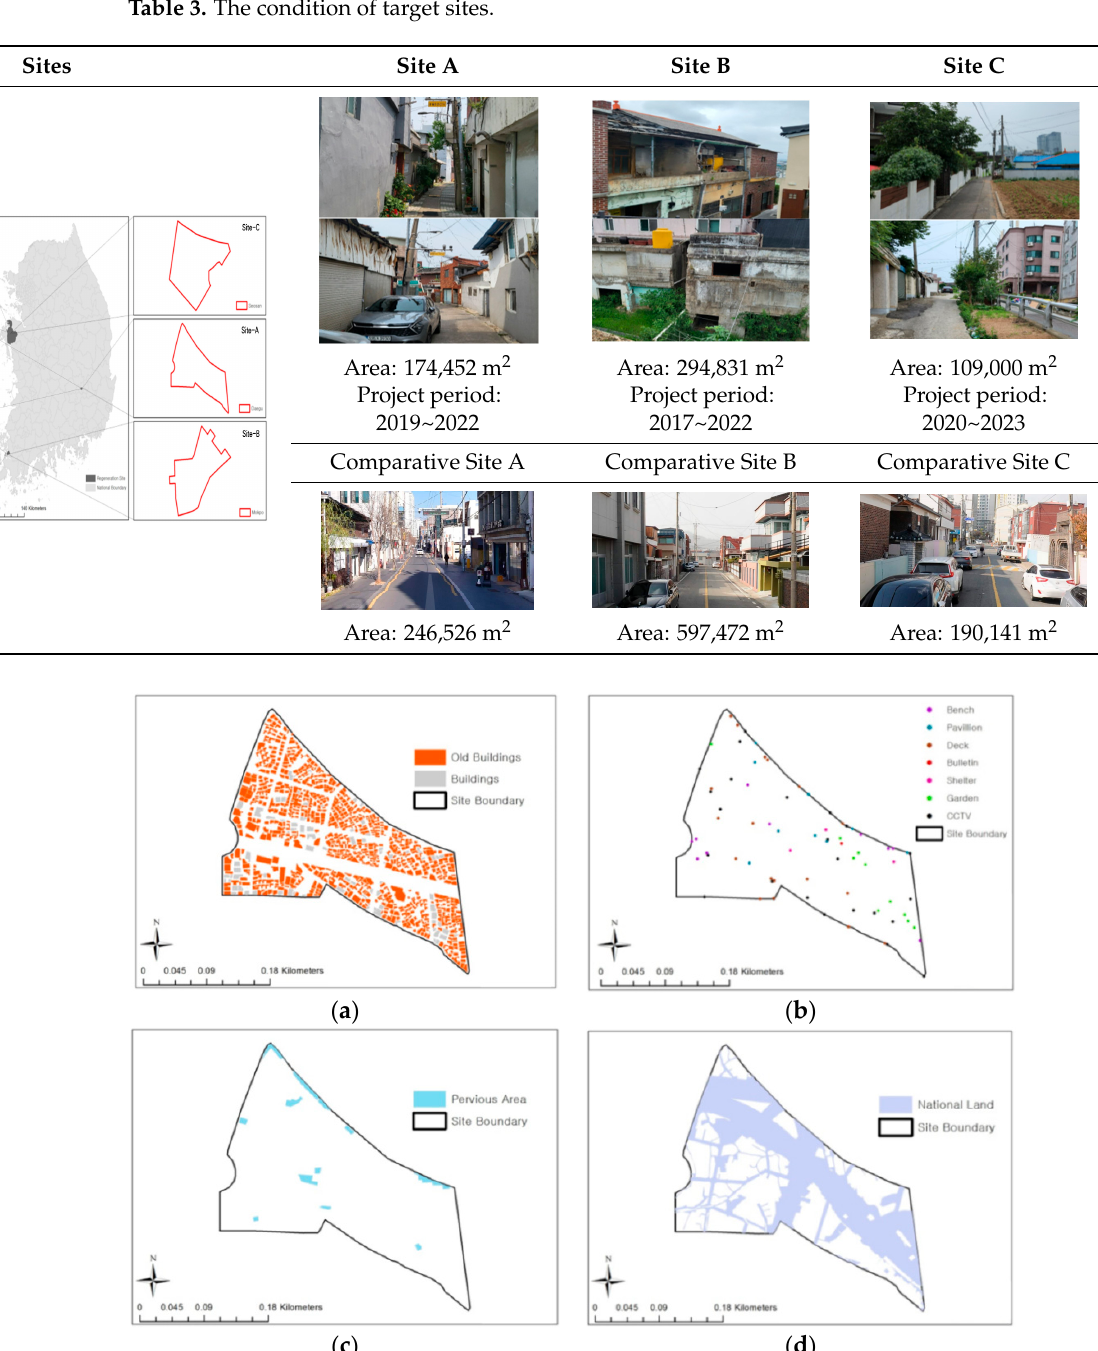
Figure 4. The examples of data construction and analysis of Site-A: ( a ) GA-3; ( b ) IT-4; ( c ) GA-2; and ( d ) GT-2.